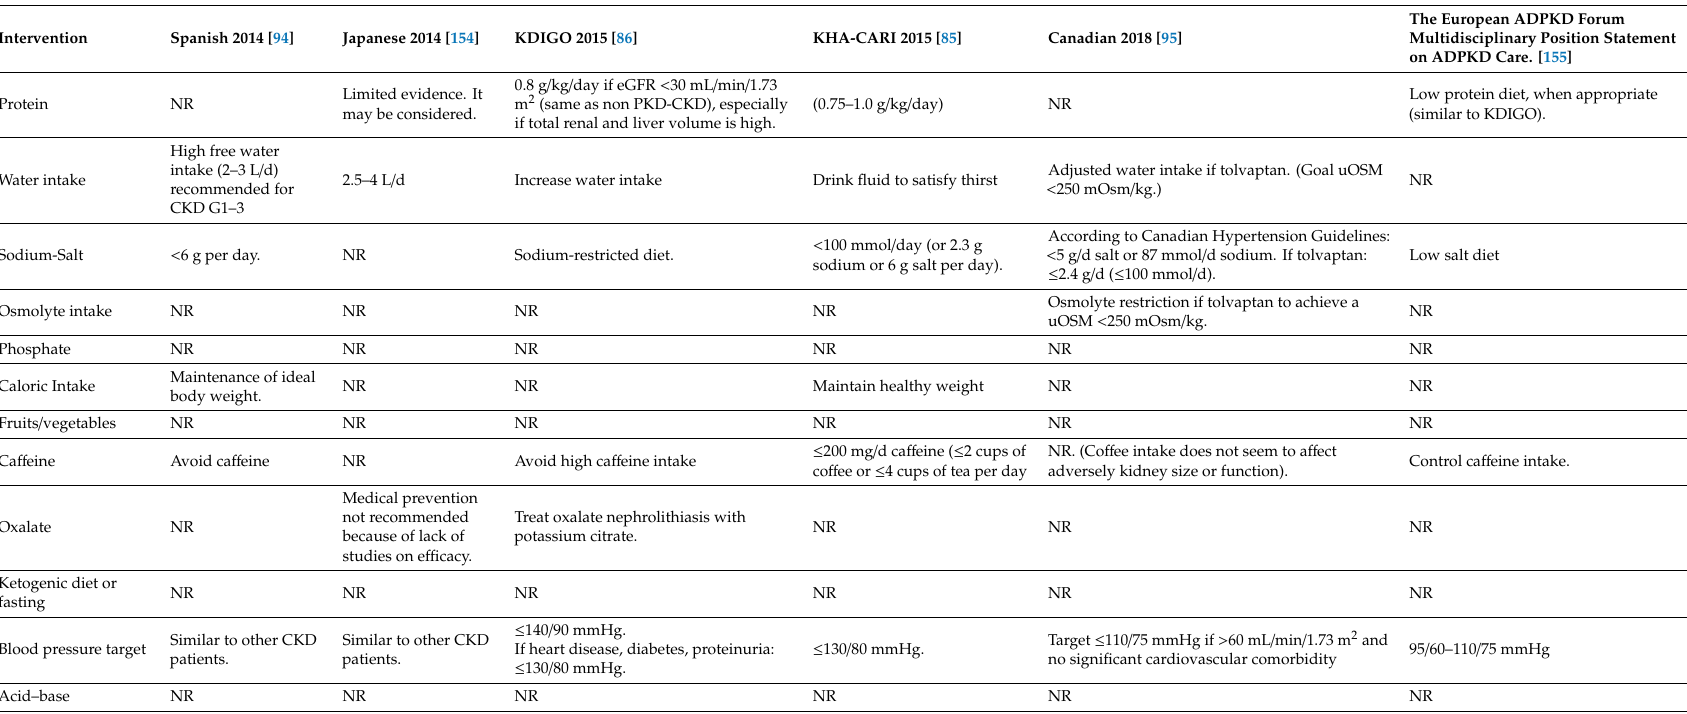
Table A1. What do guidelines say regarding dietary management of autosomal dominant polycystic kidney disease (ADPKD)?